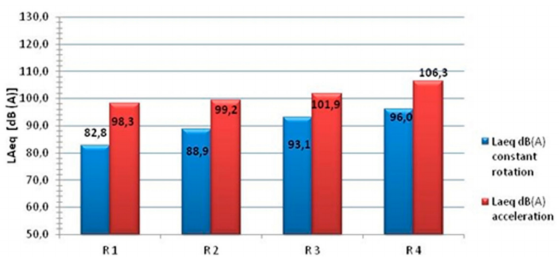
Figure 2. Influence of the type of motorcycle exhaust system on the sound level in the area of the motorcyclist’s head